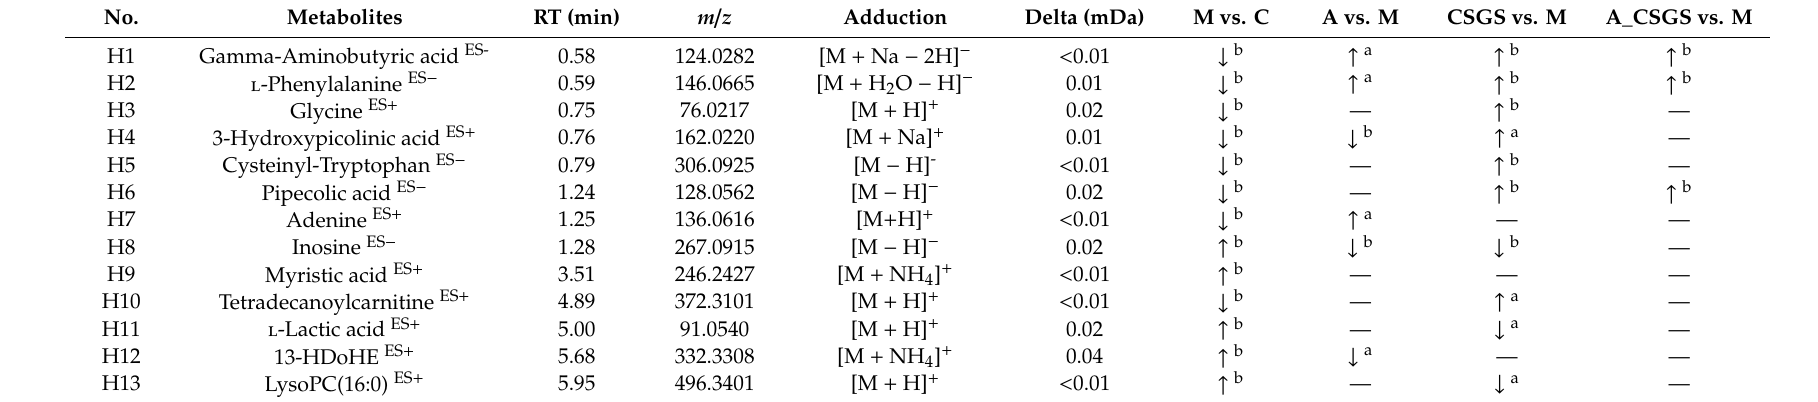
Table 1. Hippocampus di ff erential metabolites based on UPLC-Q-TOF /